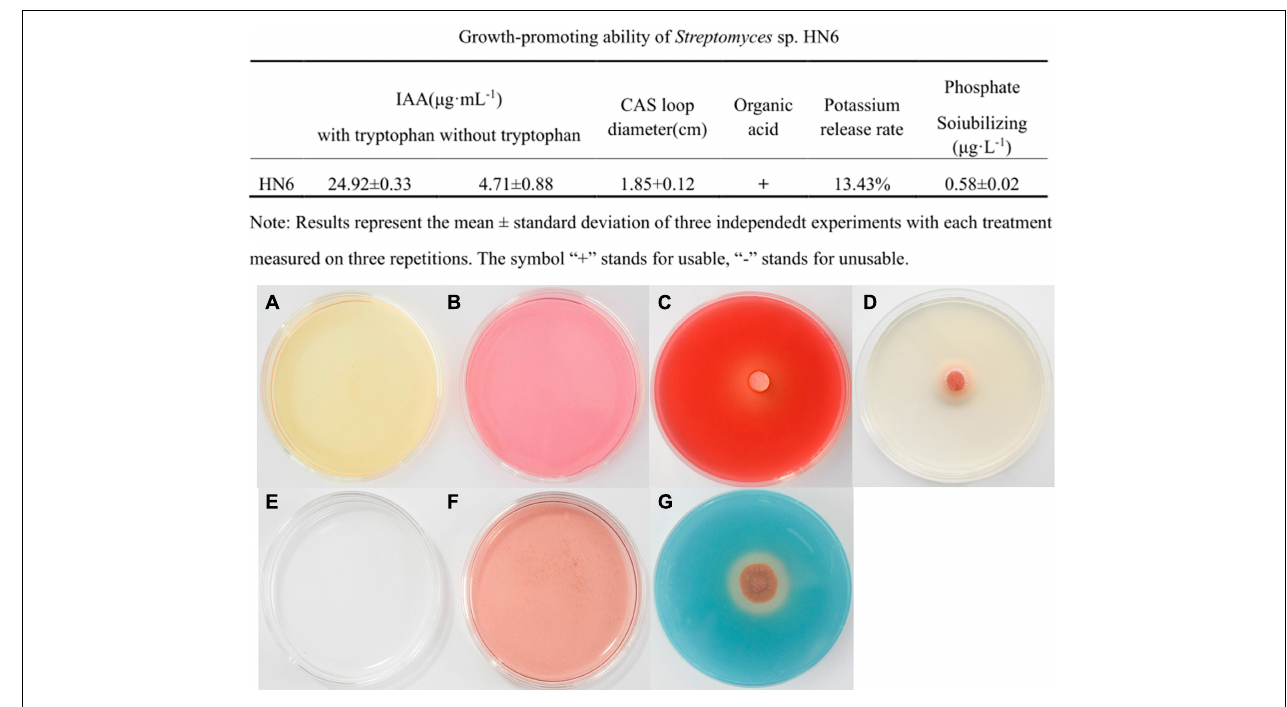
FIGURE 3 | Plant growth promotion abilities of strain HN6. (A,B) IAA production, the strain could produce IAA in Gause No. 1 liquid medium in the absence or added of tryptophan. (C) Cellulose activity. An obvious halo and transparent circles were observed around the HN6 on the cellulase detection plate. (D) Lipase activity. An obvious halo and transparent circles were observed around the HN6 on the lipase detection plate. (E,F) Produces organic acid. (G) Siderophore production. On the brilliant blue chrome-azurol S plates, strain HN6 colonizes the diameter of the orange zone.